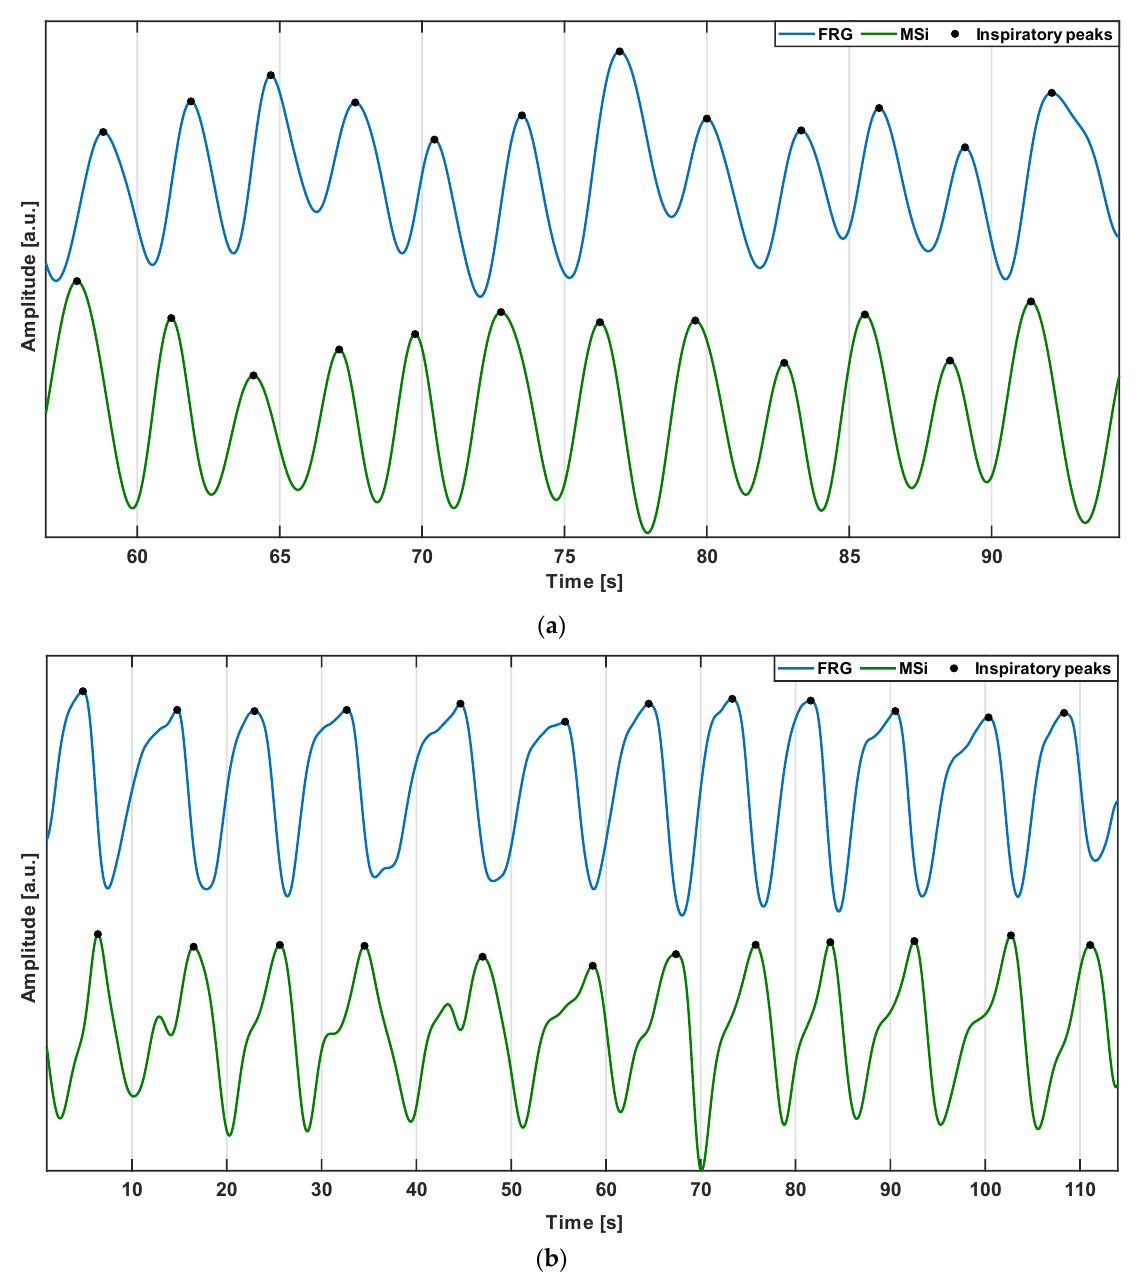
Figure 5. Excerpts of the FRG signal (blue line) and MSi trend (green line) from: ( a ) subject #2; ( b ) subject #4.